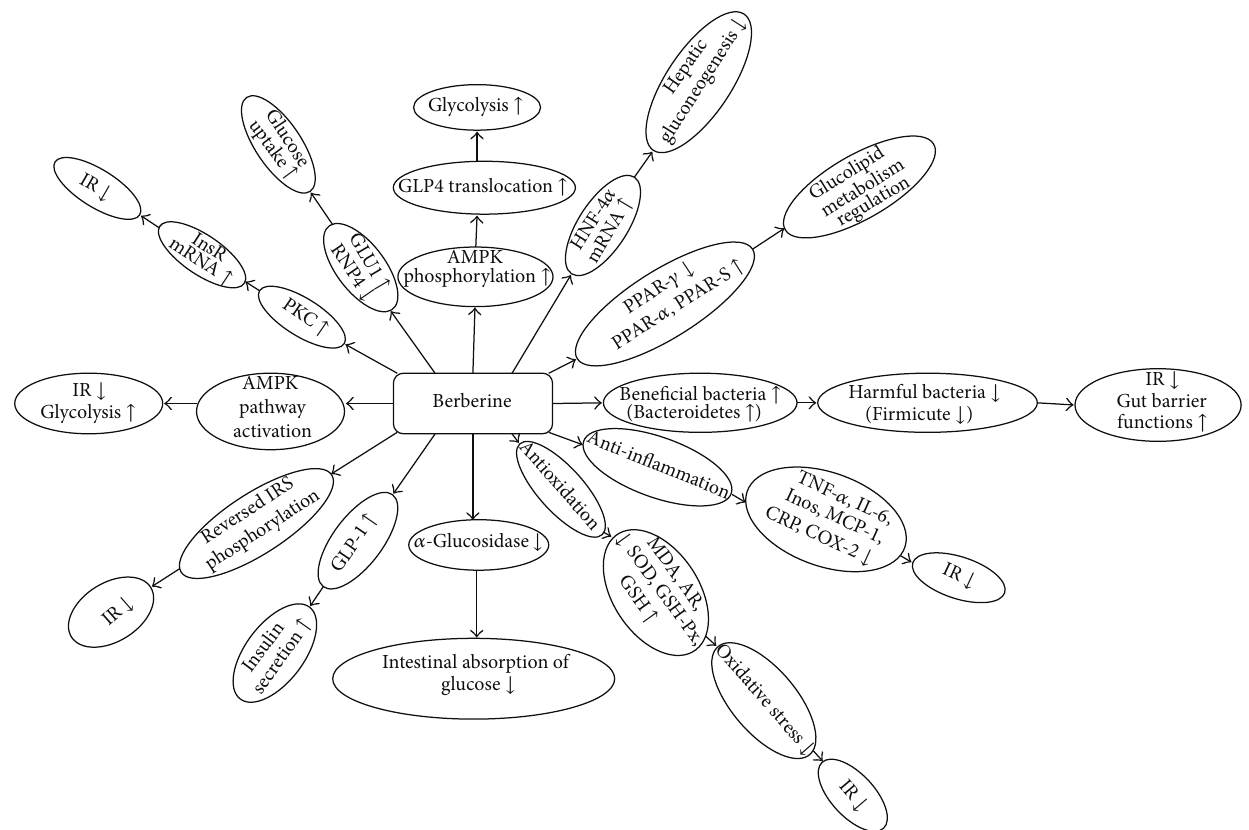
Figure 2: Main mechanisms of BBR on glucose metabolism. Note: AMPK: adenosine monophosphate- (AMP-) activated protein kinase; HNF-4:hepaticnuclearfactor4alpha;PPARs:peroxisomeproliferator-activatedreceptors;TNF- 𝛼 :tumornecrosisfactor- 𝛼 ;IL-6:interleukin- 6; INOS: inducible nitric oxide synthase; MCP-1: monocyte chemoattractant protein-1; CRP: C-reaction protein; COX-2: cyclooxygenase-2; IR: insulin resistance; MDA: malondialdehyde; AR: aldose reductase; SOD: superoxide dismutase; GSH-PX: glutathione peroxidase; GSH: glutathione; GLP-1: glucagon-like protein-1; PKC: protein kinase C; InsR: insulin receptor; GLU1: glucose transporter type 1; RNP4: retinol binding protein 4; GLUT4: glucose transporter type